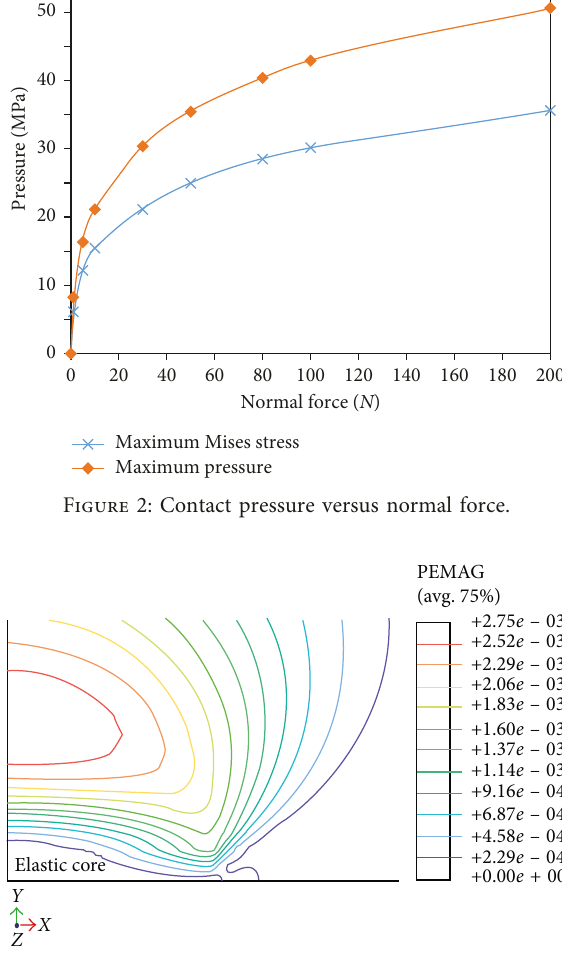
Figure 3: Initiation of plastic flow in spherical contact (a quarter of cross section from the center of the upper sphere). PEMAG, plastic strain magnitude.